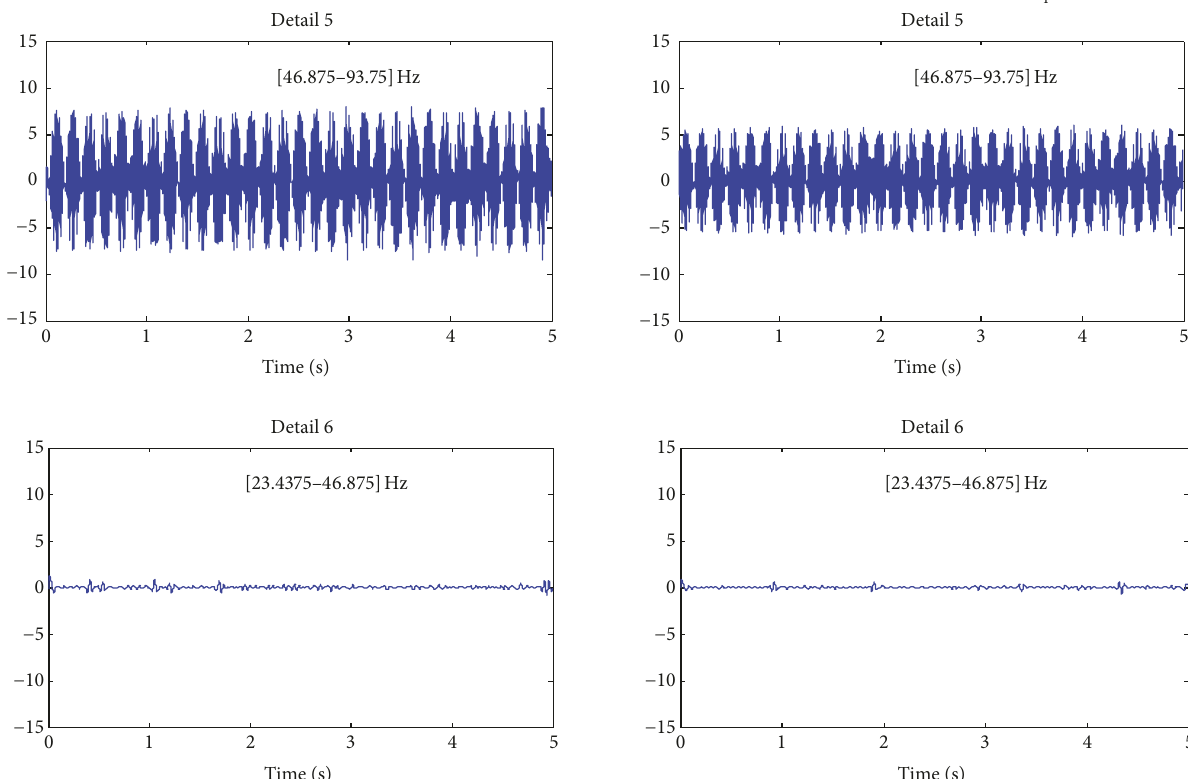
Figure 10: Details signal decomposition for healthy and faulty open-circuit at 𝐾 1 cases.